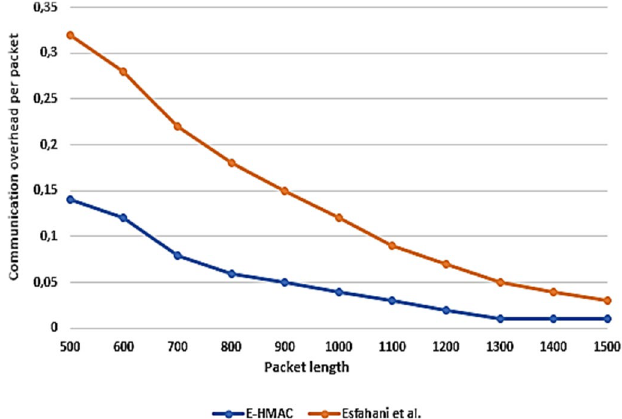
Figure 2. Communication overhead per coded